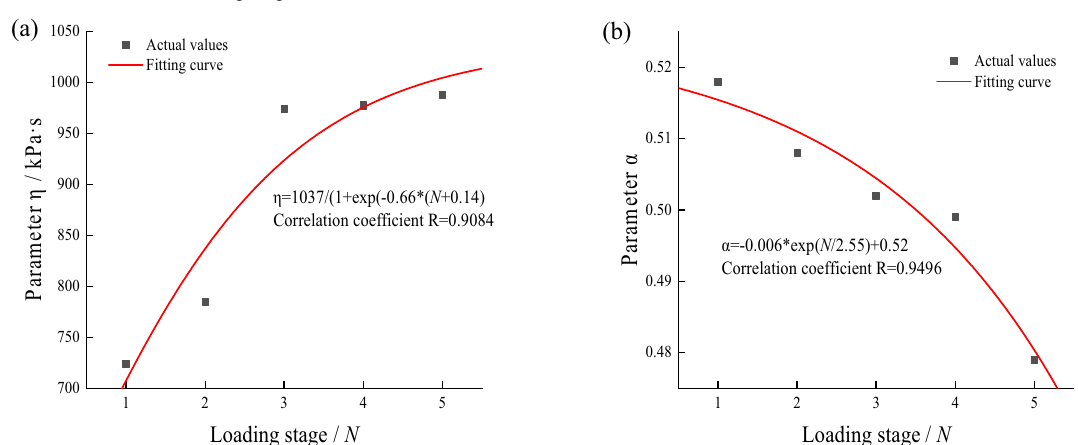
Figure 14. Fitting parameters of saturated soft clay under single-stage intermittent loading and its variation curve with loading